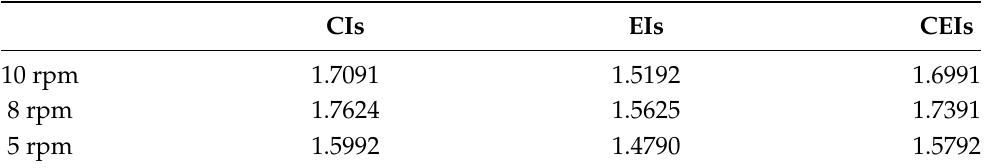
Table 4. Training time (in seconds) of random forest classifier by the use of classic indicators (CIs), entropy indicators (EIs), and classic and entropy indicator (CEIs) for signals at 5, 8, and 10 rpm. CIs EIs CEIs 10